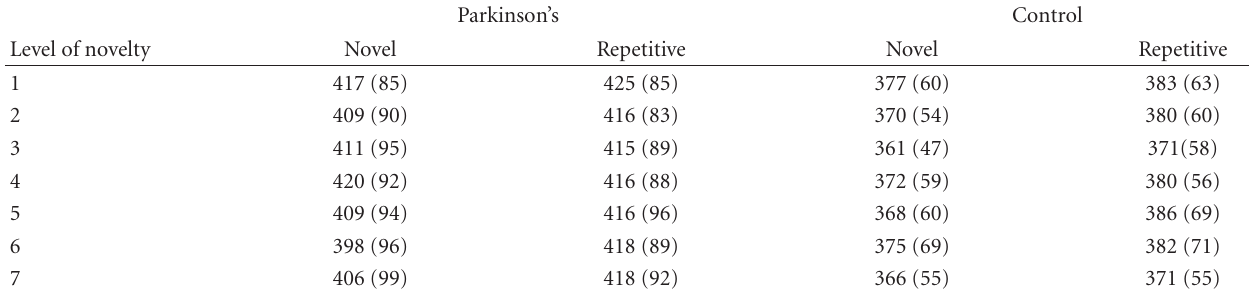
Table 1: Response times (and SDs) in milliseconds for the PD and control participants in the novelty attention task. Parkinson’s Control Level of novelty Repetitive Novel